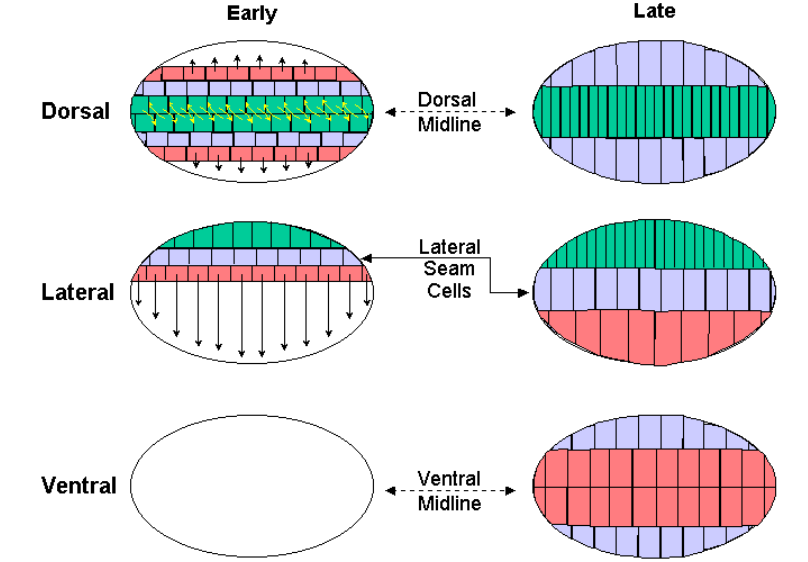
FIGURE 1. Schematic representation of the cell movements during dorsal intercalation and ventral enclosure. Initially, each side of the ventral midline contains three rows of epidermal cells. The dorsal-most rows (green) slide past one another as indicated by the arrows during dorsal intercalation, forming into a single row. Later, the ventral row (red) on either side of the dorsal midline migrates as indicated by the arrows to the ventral midline, enclosing the embryo.